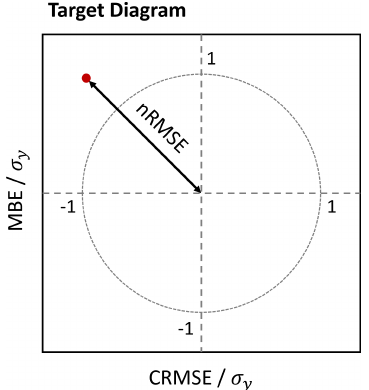
Figure 2. A schematic of the structure of the target diagram. The red point indicates the position of an exemplary point in the